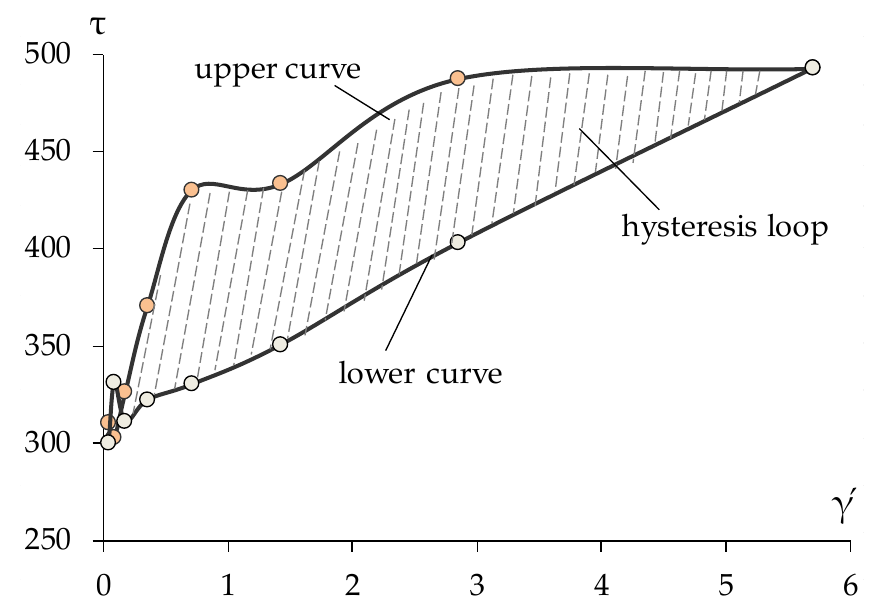
Figure 3. Thixotropy of the sample.